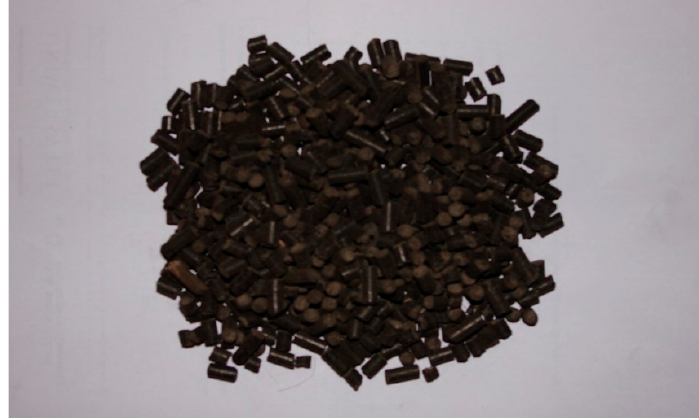
Figure 1. Organomineral fertilizer applied to the preceding crop (maize grown for silage).